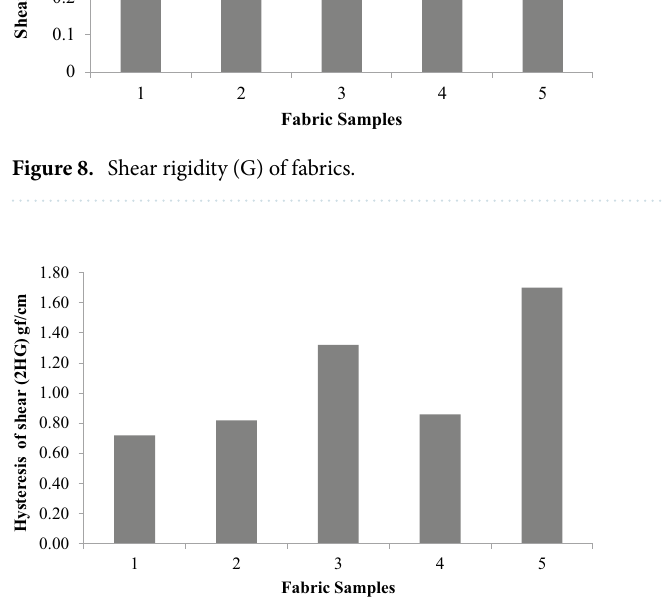
Figure 9. Hysteresis of shear (2HG) of fabrics.